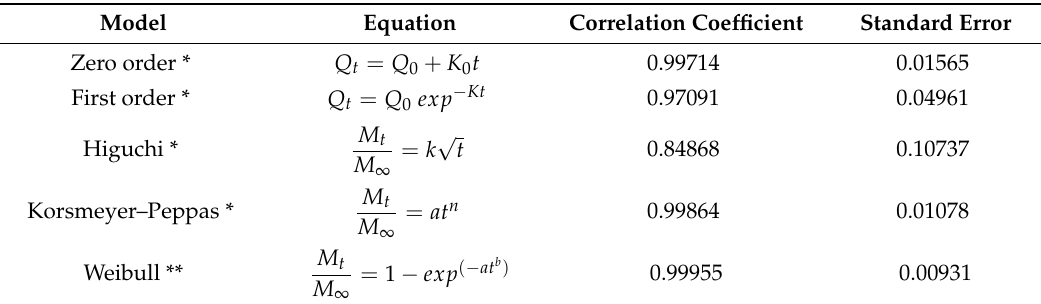
Table 2. Mathematical models fitted to experimental release